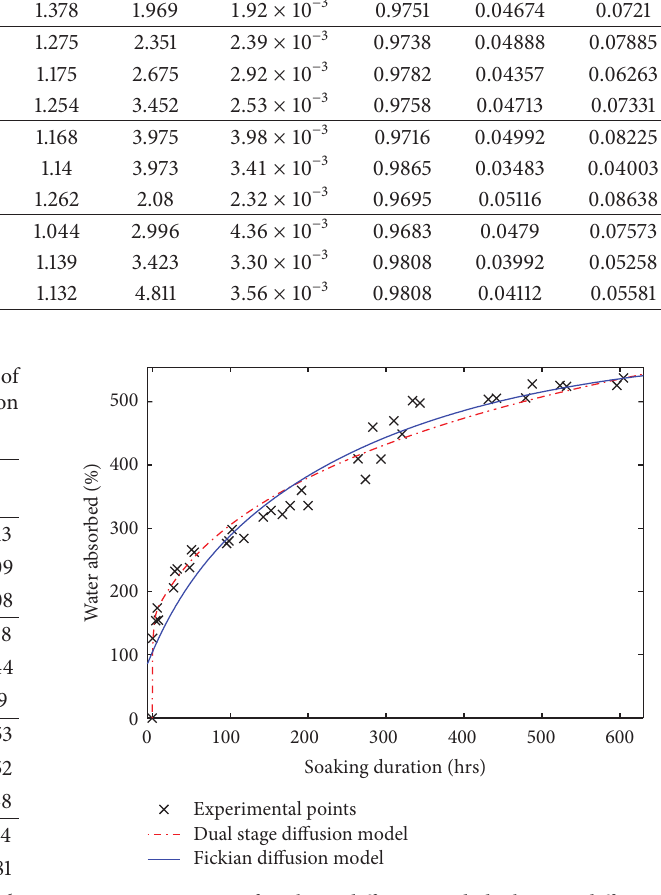
Figure 6: Curves of Fickian diffusion and dual stage diffusion models for the Raffia vinifera fibres located at the half radius after the base of the stem